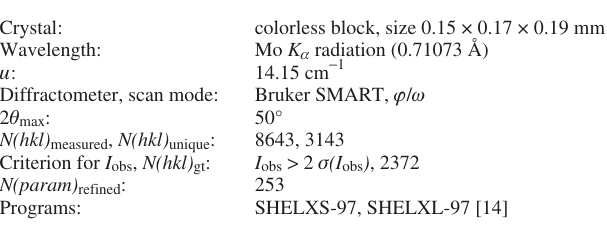
Table 1. Data collection and handling.